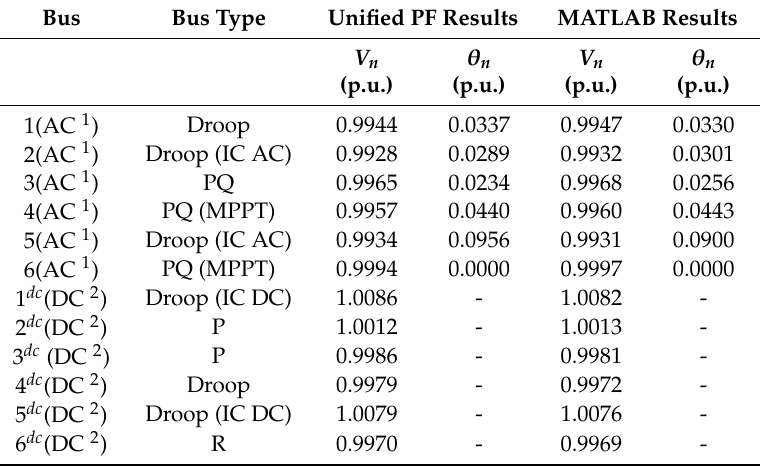
Figure 5. 12-bus IHMG test system operating in mode 5. Table 6. Test results of the voltage in the 12-bus IHMG system.